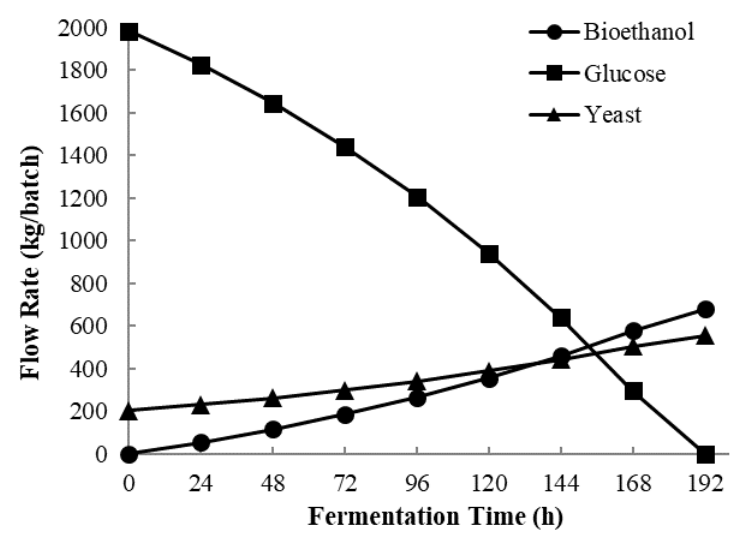
Figure 5. The relationship between fermentation time and flow rate of bioethanol, glucose and yeast leaving fermenter simulated by SuperPro Designer©. v9.0.